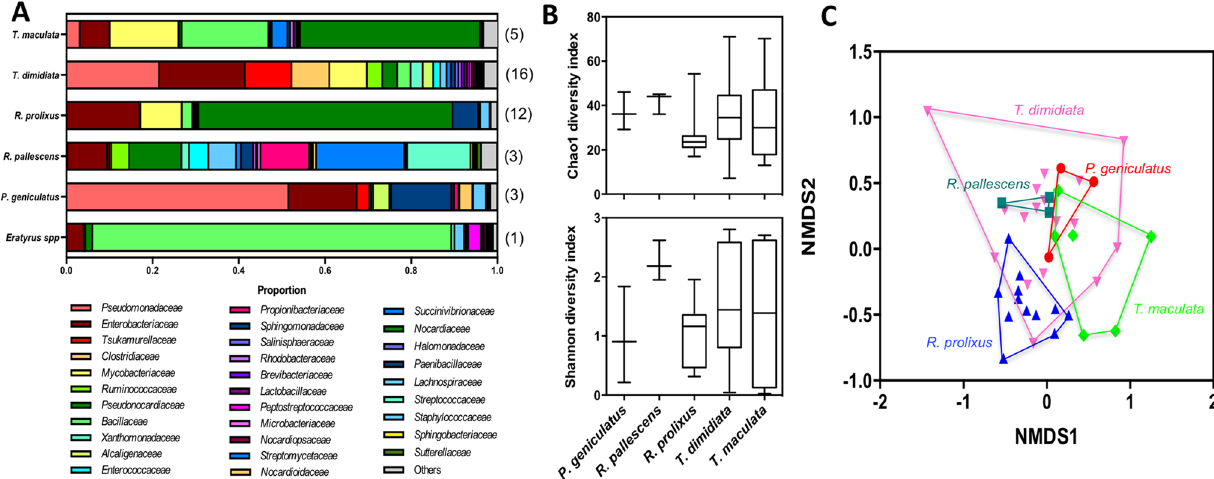
Figure 6. Composition of triatomine gut microbiota. ( A ) Proportion of bacterial families according to triatomine species. Taxonomic groups are color-coded as indicated and numbers in parenthesis on the right indicate sample size for each species. ( B ) Comparison of Chao1 (top panel) and Shannon (bottom panel) diversity indices among species. There were no significant differences among species (F = 0.82, P = 0.52 and F = 1.47, P = 0.23, respectively). ( C ) NMDS analysis of beta diversity among species. Microbiota composition was significantly different among species (PERMANOVA, F = 1.73, P = 0.006).